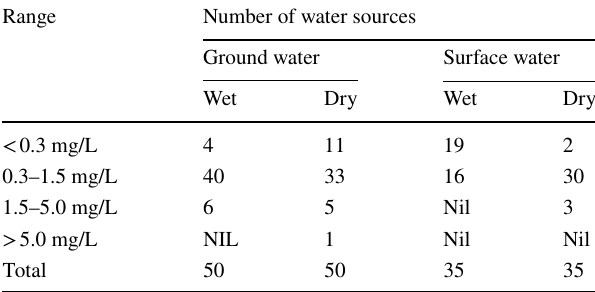
Table 6 Classification based on iron content (mg/L) Range Number of water